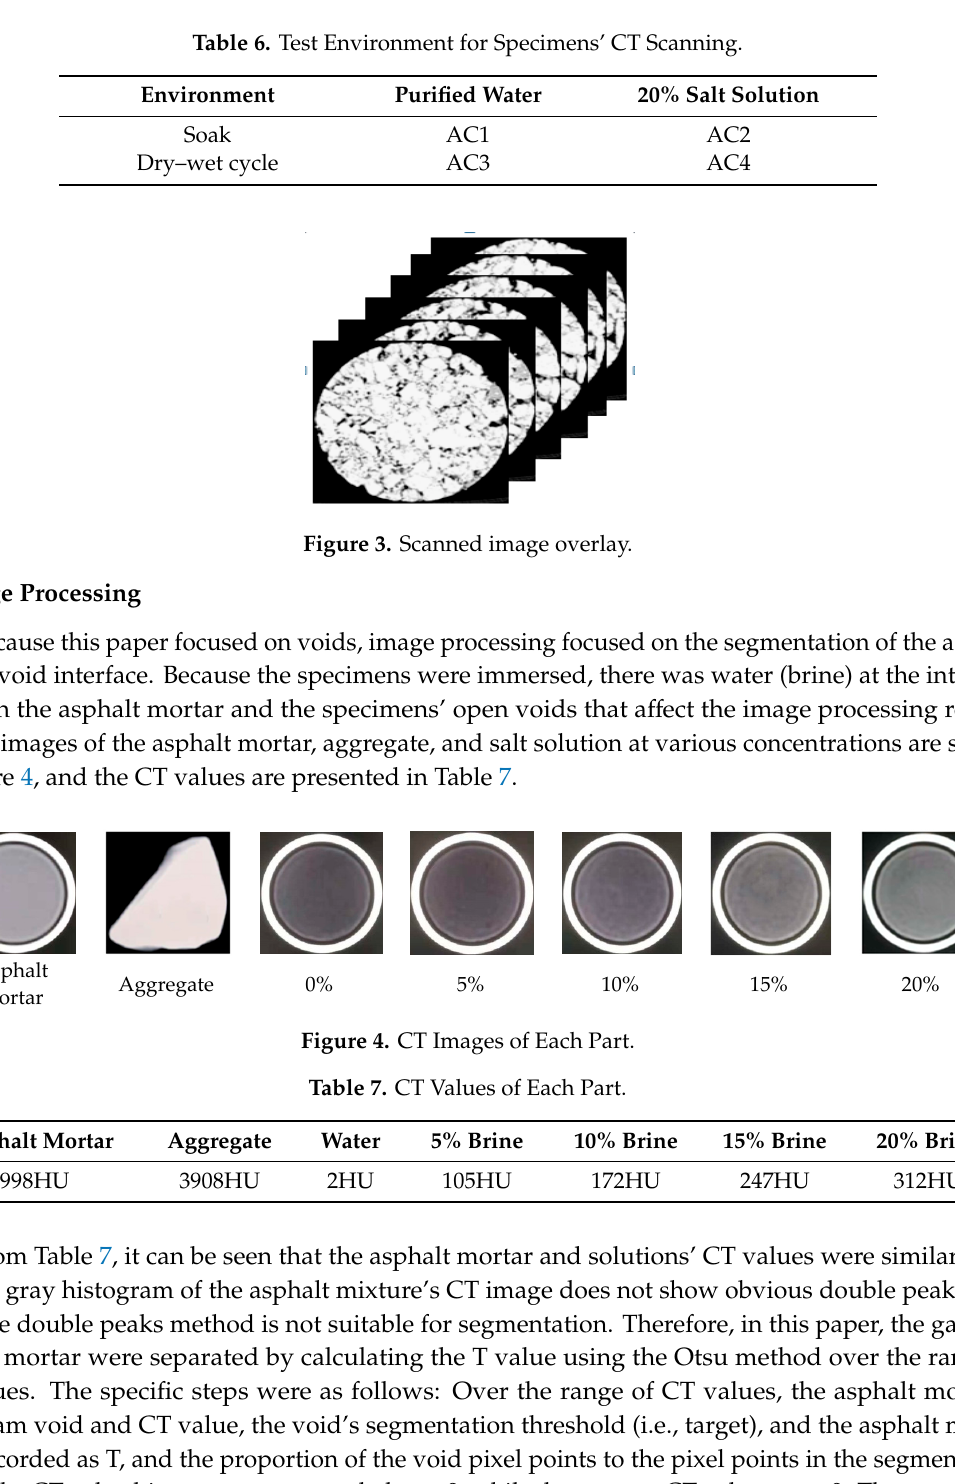
Table 6. Test Environment for Specimens’ CT Scanning.